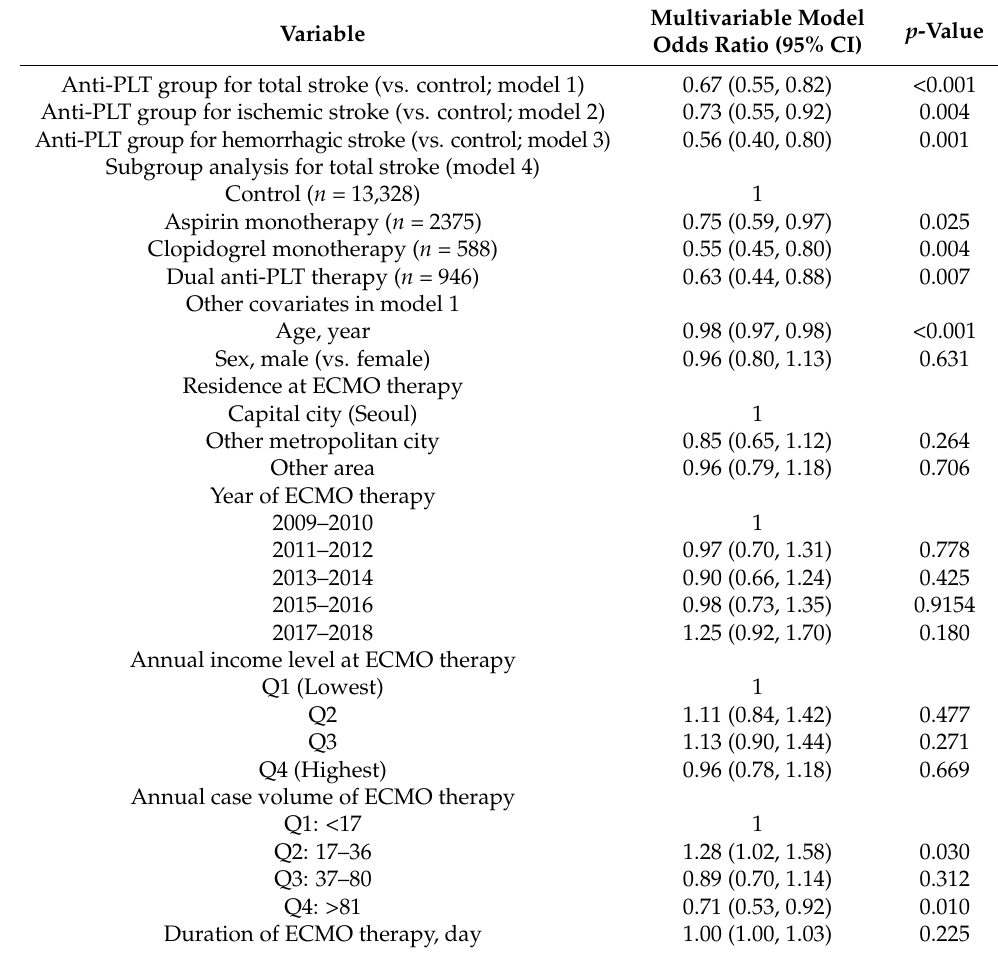
Table 2. Multivariable logistic regression model for stroke development in the entire cohort. Multivariable Model Variable Anti-PLT group for total stroke (vs. control; model 1) 0.67 (0.55, 0.82)